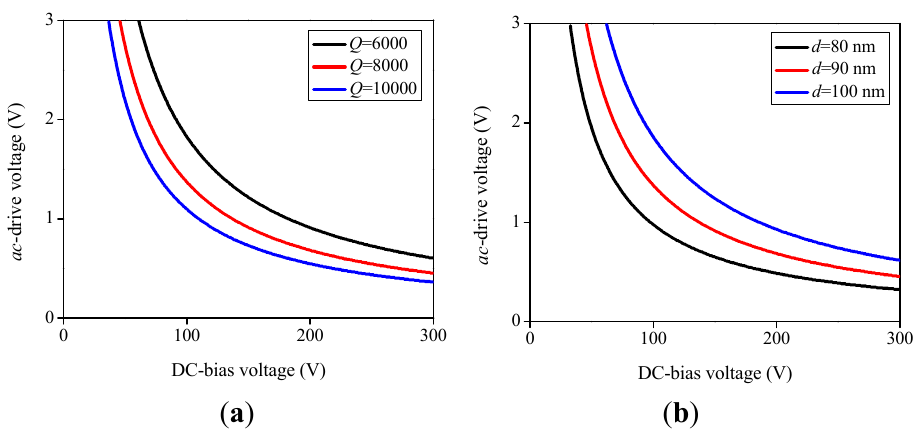
Figure 7. Variation of the non-dimensional radial displacement with DC-bias voltage for EWG mode ring resonator with d = 90 nm and ( a ) v